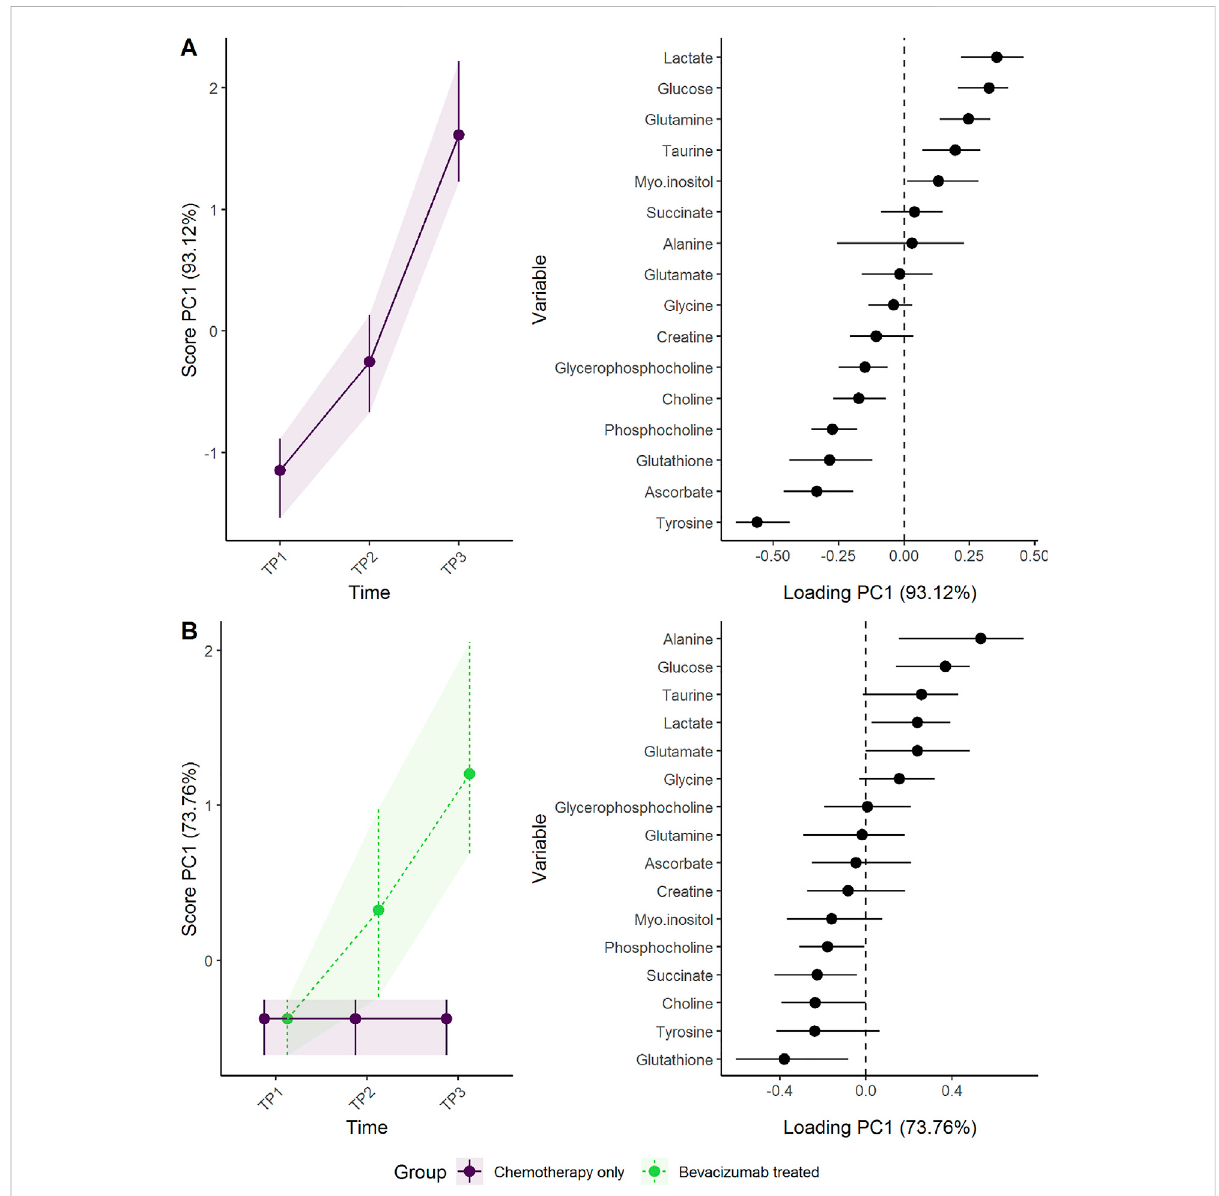
FIGURE 7 Time development of tumor biopsy metabolome before and during cancer treatment. (A) The time development of the participants receiving chemotherapy only is isolated in the upper panels, whereas (B) the lower panels visualize how the metabolome differs between the groups. The levels of metabolites with high loading is increasing when the scores increase and vice versa